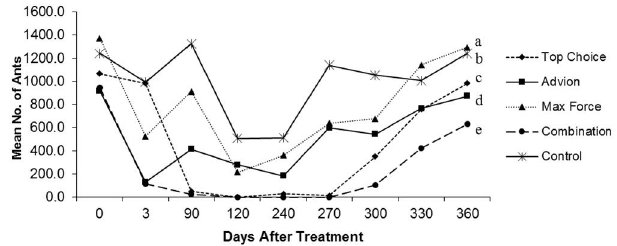
Fig 2. Mean number of foraging RIFA in experimental plots before and after product applications (one-year study). Trend lines followed by the same letter are not significantly different (α = 0.05).